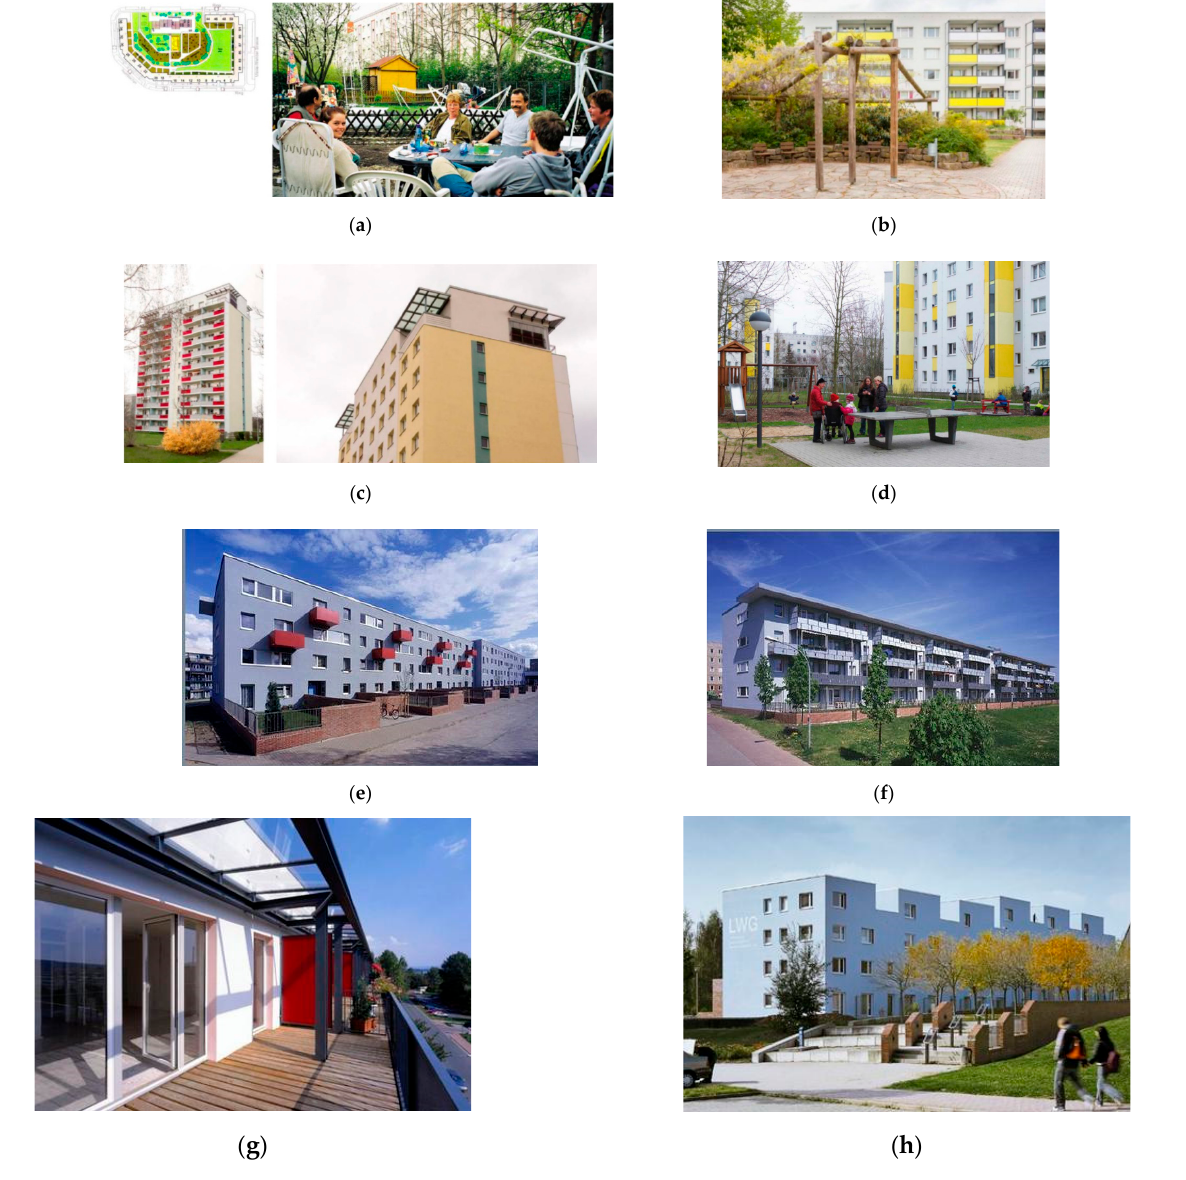
Figure 9. ( a ) Garden plots centered on the courtyard of a residential building. ( b ) Landscaping example for a residential courtyard within the Lobeda area, Jena—landscaping example where a tree is used, and creating green space is the main landscaping element. ( c ) Additional stories within the Lobeda area, Jena. Similar projects were implemented from 1990–2000. ( d ) Social ties between residents are a key safety factor. Wuhletal cooperative courtyard. Source: M. Melnikova “Not just panel buildings”. ( e , f , h ) Projects for the reconstruction of buildings by the German architect Stefan Forster. ( g ) Open terraces instead of the former balconies. Source: